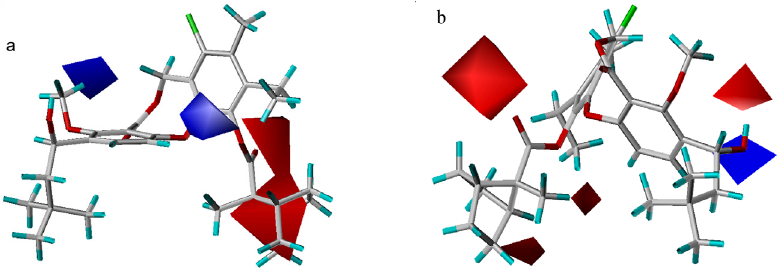
Figure 6. Electrostatic maps from the CoMSIA model (a) and CoMFA model (b). Compound 55 is shown inside two field models. Red isopleths (contour level: CoMFA: – 0.02; CoMSIA: –0.015) define regions where electronegative groups will increase the activity, while blue contours (contour level: CoMFA: 0.03; CoMSIA: 0.012) define regions where an increase in positive potential will enhance the